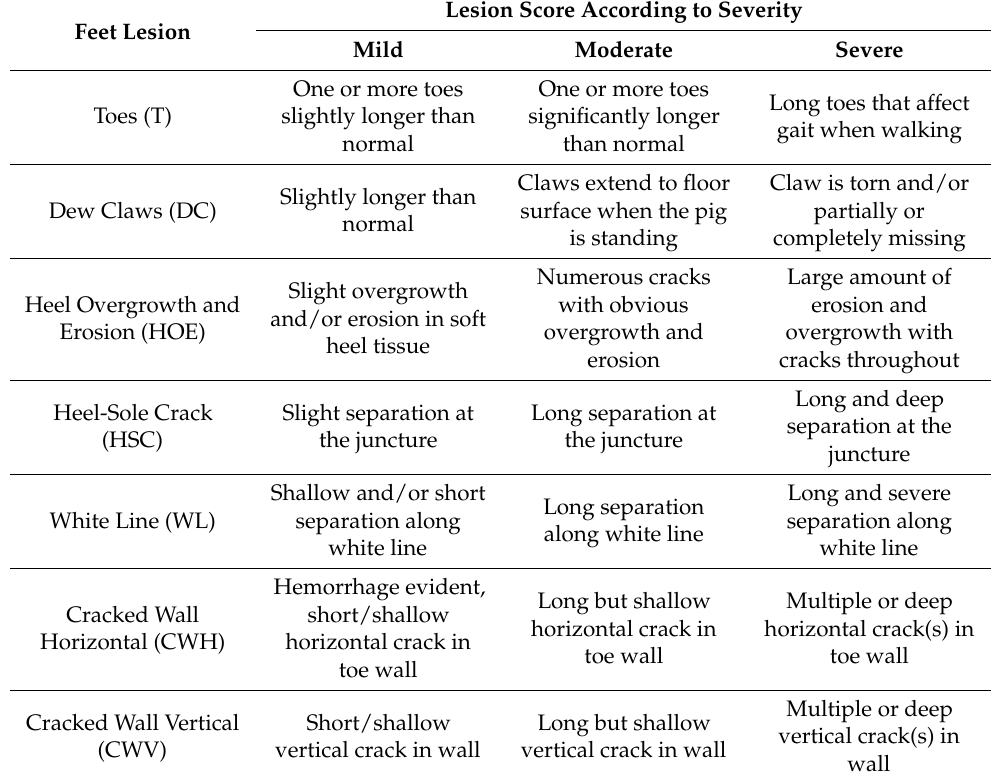
Table 2. Feet lesion scoring performed on sows upon entry and exit from the farrowing room. Feet